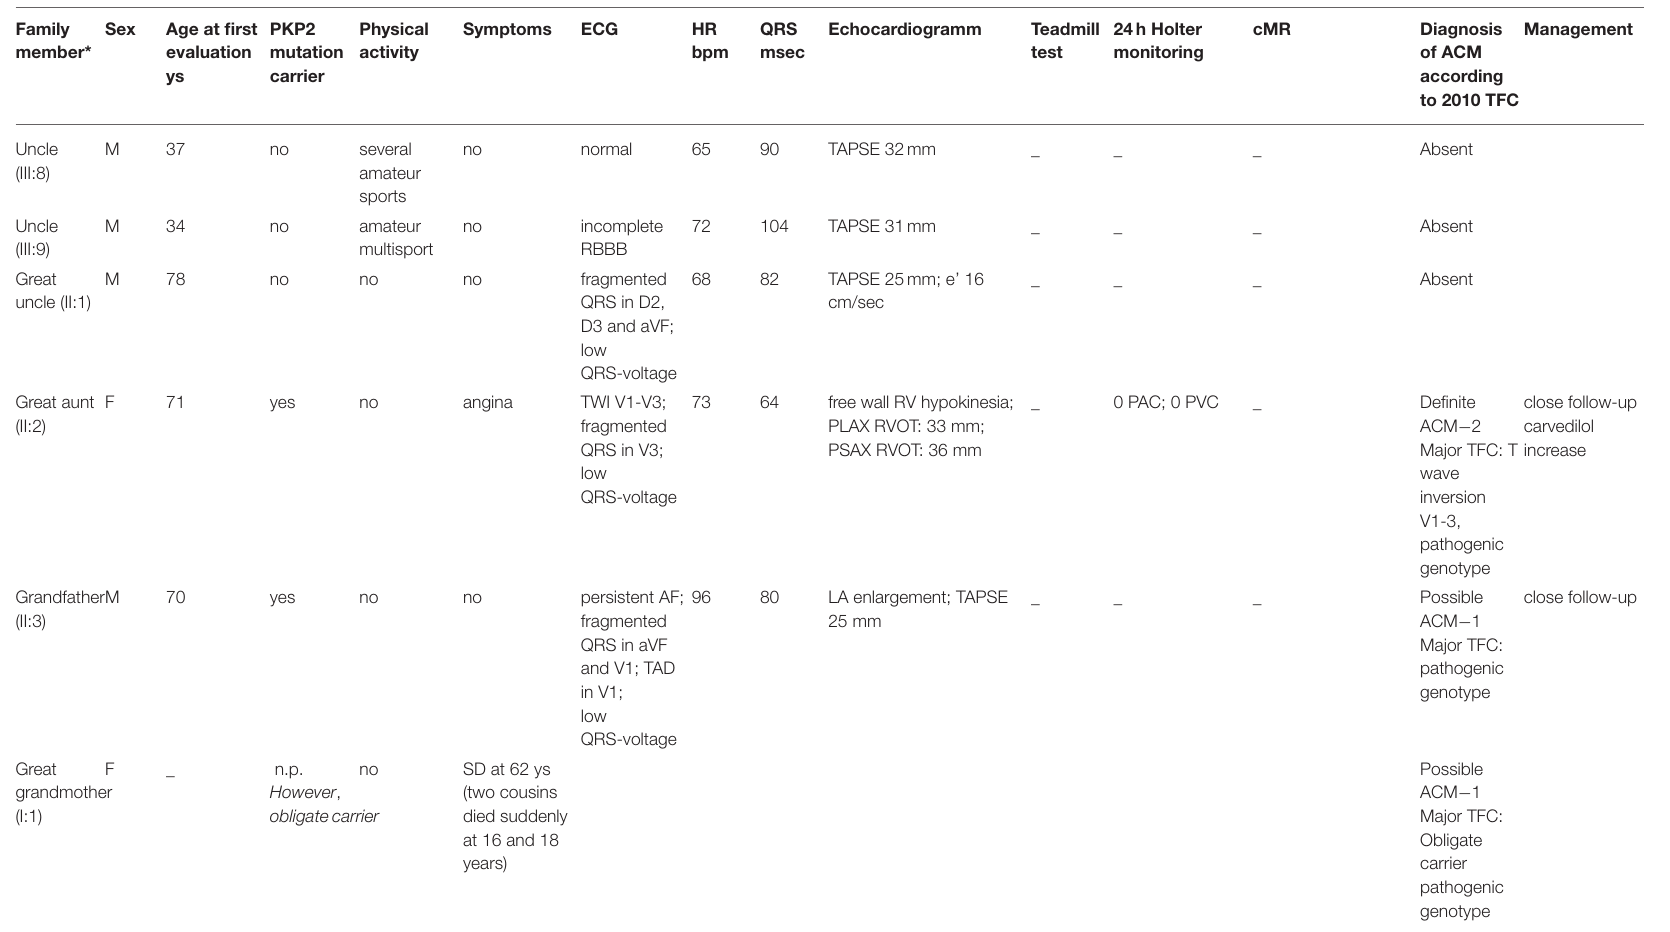
AF, Atrial fibrillation; ARVC, arrhythmogenic right ventricular dysplasia; AVB, atrioventricular block; cMR, cardiac magnetic resonance imaging; F, female; HR, heart rate; LA, left atrium; LBBB, left bundle branch block; LV, left ventricle; M, male;n.p.,notperformed;PAC,prematureatrialcontraction;PVC,prematureventricularcontraction;RBBB,rightbundlebranchblock;SD,suddendeath;TAD,terminalactivationduration;TFC,TaskForceCriteria;TWI,Twaveinversion. * Roman and Arabic numerals correspond to generation and pedigree number shown in Figure 1